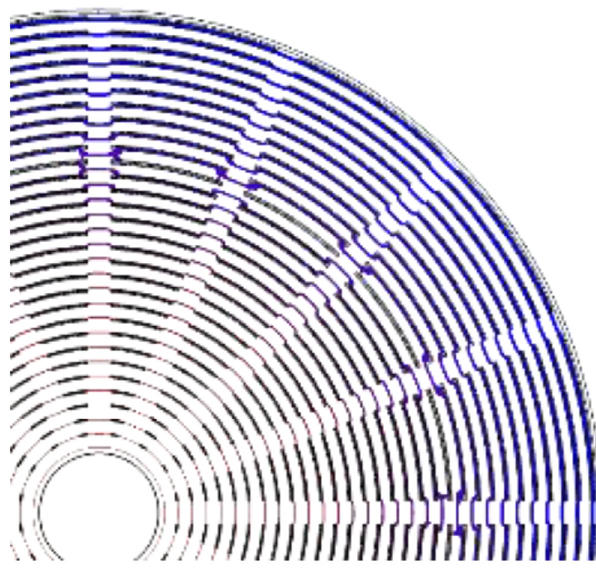
Fig. 7. Isothermal contours for the proposed metamaterial.